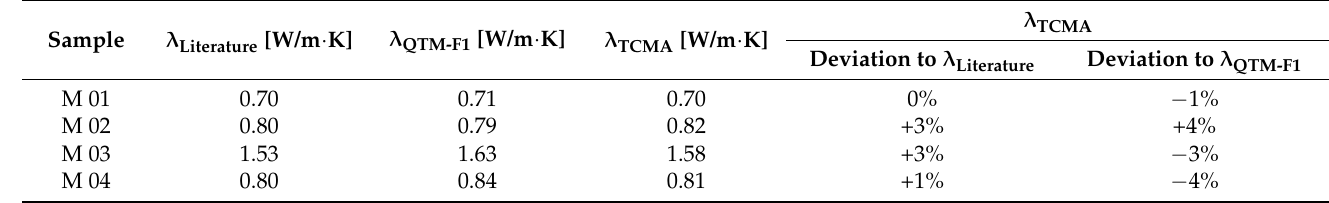
Table 6. Thermal conductivity measurements and deviations.